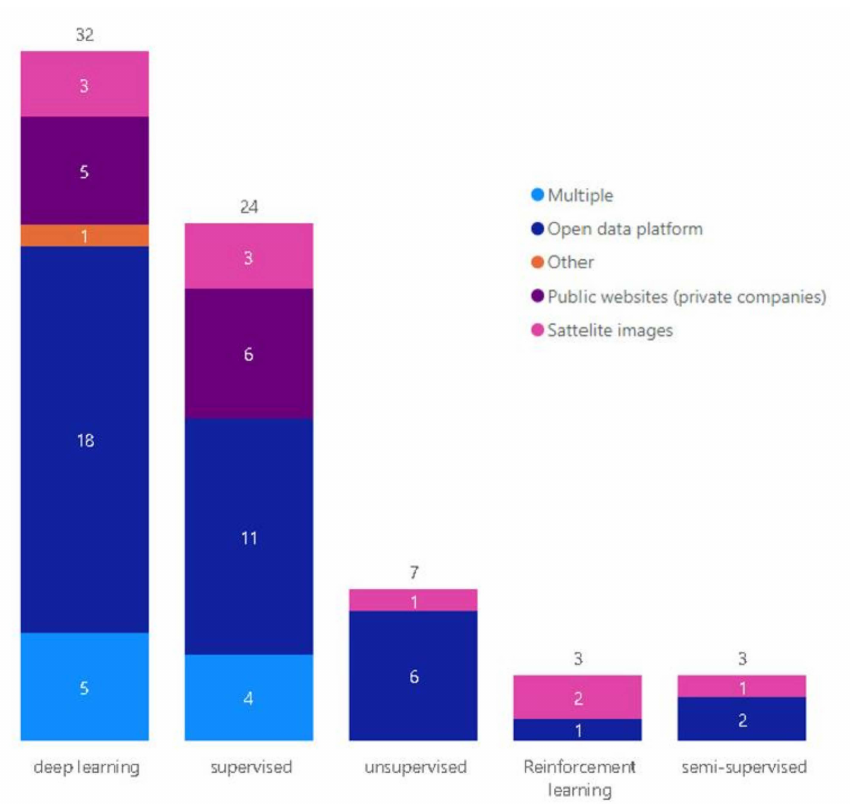
Figure 13. Open data sources used in applications for each of the ML